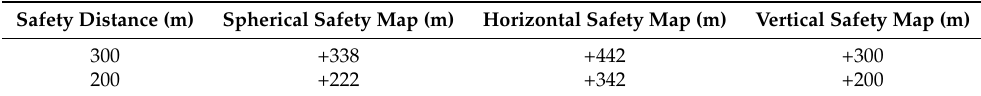
Figure 9. Map segmentation and parallel computing. Table 1. Comparison of safety maps.